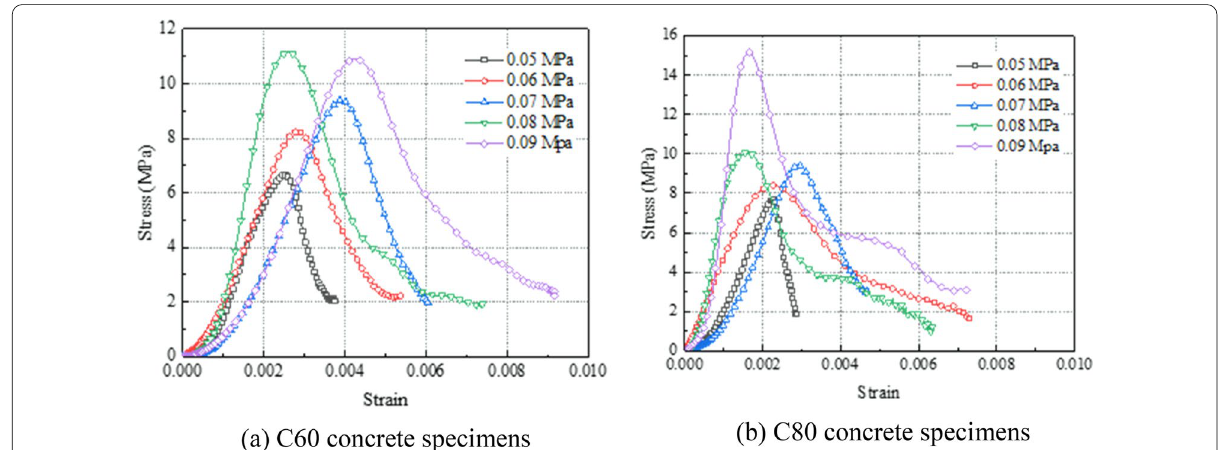
Fig. 7 Dynamic splitting test stress–strain response of high-strength concrete under different impact